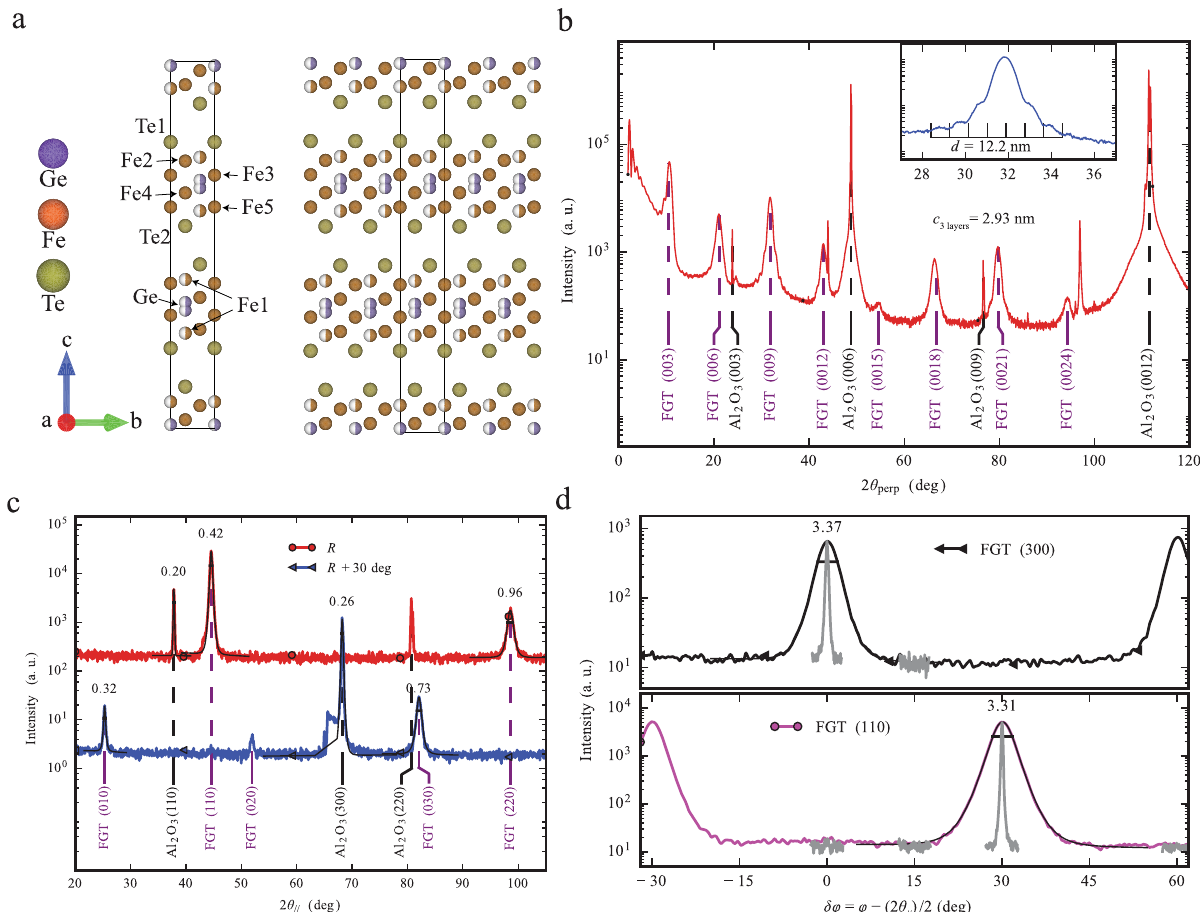
Fig. 2 Structural characterization of Fe 5 GeTe 2 by X-ray diffraction. a Unit cell projected along [100], with FGT layers separated by the vdW gap between adjacent Te sublayers. The right-side image shows the same projection for several repetitions of the unit cell. The occupation probability is represented by half- fi lled solid balls. Images generated using VESTA software 52 for the crystallographic model of ref. 7 . b Out-of- plane θ /2 θ XRD scan of the fi lms, showing Al 2 O 3 (00 l ) and Fe 5 GeTe 2 (00 l ) peaks. Inset: zoom on the (009) Bragg peak to show the fringes used to estimate the fi lm thickness. c In-plane radial XRD scans along the (110) reciprocal direction ( R ), and (010), ( R + 30°). Each diffraction peak is labelled with the full widh at half maximum. d In-plane azimuthal XRD scan over the families {110} and {300} showing the 6-fold symmetry of the crystal. Gray lines show the corresponding radial